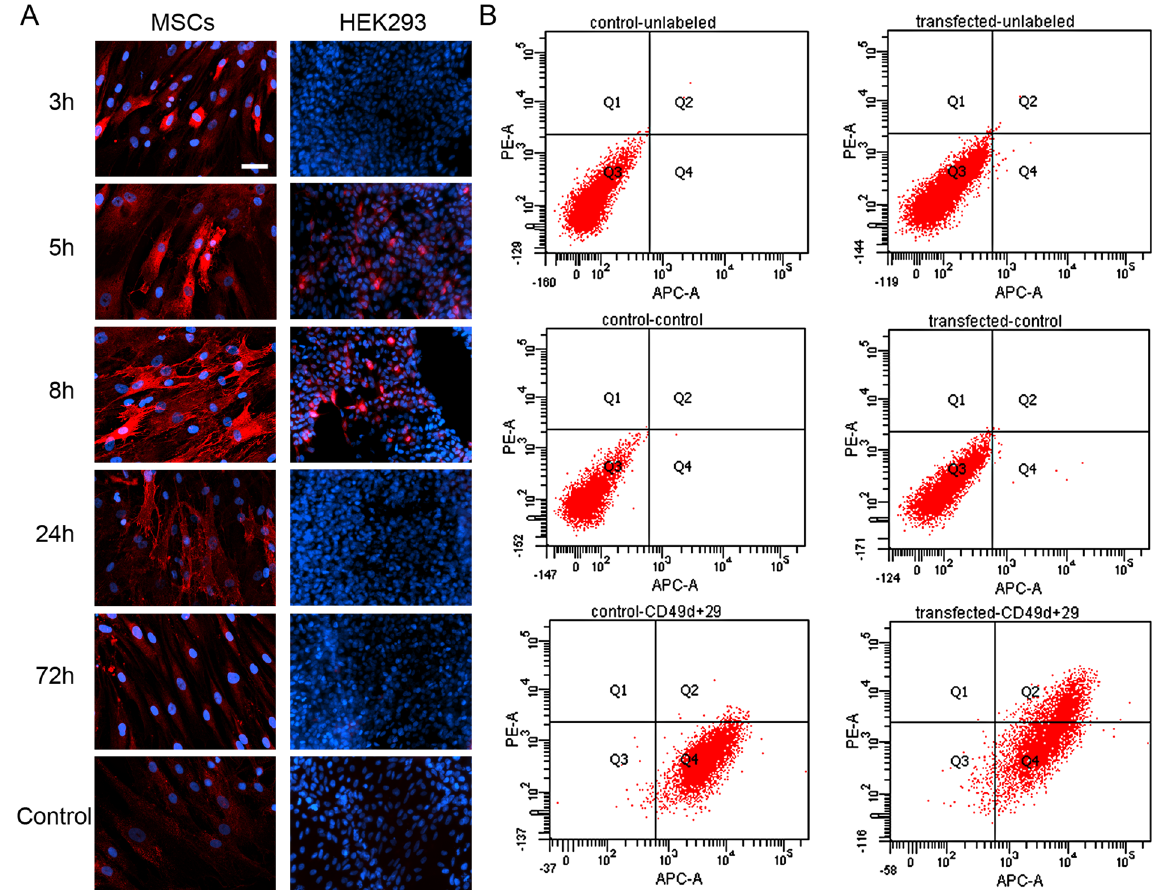
Figure 7. ITGA4 protein distribution in (ARCA)-ITGA4-mRNA transfected MSCs. Time-course of ITGA4 protein production – note its translocation from perinuclear area in 3 and 5 hour time-points toward the cell membrane in 8 and 24 hour time points ( A ). The presence of ITGA4 protein on the cell membrane was confirmed in living cells by flow cytometry performed 20 h after transfection ( B ). red – ITGA4 protein, blue – Hoechst 33258. Scale bar: 20 µ m.